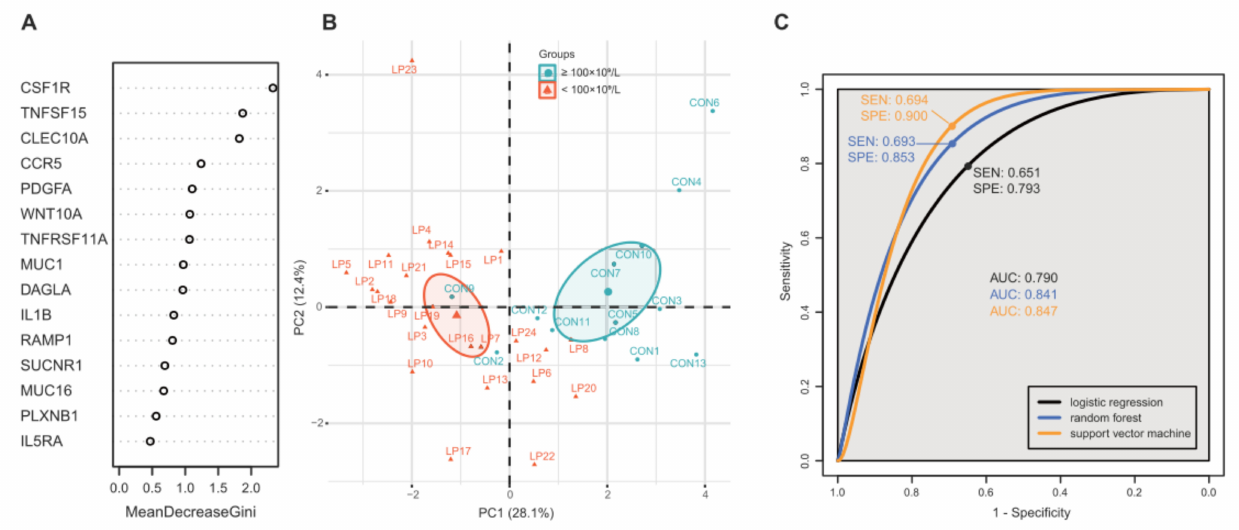
Figure 3. ( A ) Variable importance in random forests considering mean decrease in Gini index. ( B ) Principal component (PC) analysis reveals differences between platelet-decreased acute myeloid leukemia (PD-AML; red circle) and platelet-not-decreased AML (PND-AML; sky blue circle). X and Y axes show PC1 and PC2, respectively, and the percent variation explained by each component is shown in parentheses. ( C ) Receiver operating characteristic curves were plotted and the areas under curve (AUC) of the top three features models (logistic regression, random forest and support vector machine) were calculated. The AUC values, sensitivities, and specificities are in the right